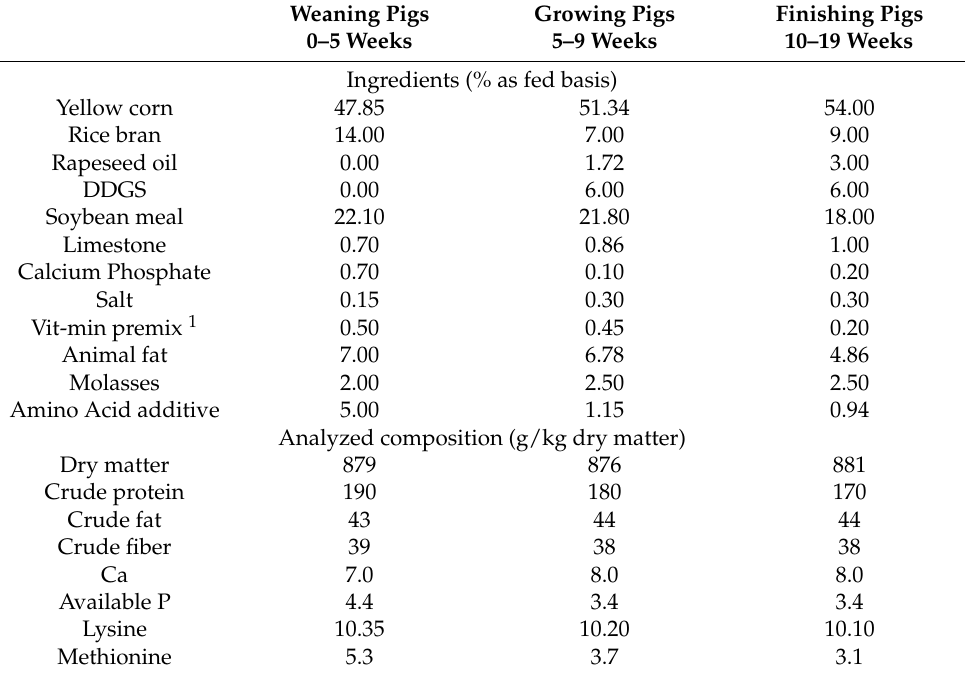
Table 1. Diet formulae and chemical composition of the experimental